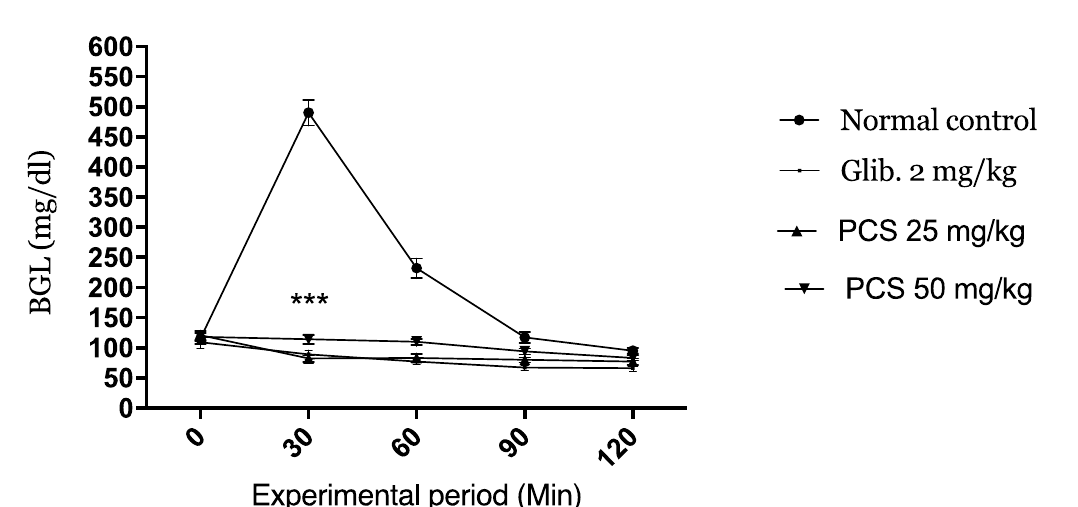
Figure 5. Effect of PCS on blood glucose level in Alloxan-induced diabetic mice during oral glucose tolerance (OGTT). Values are expressed as mean ±SD ( n = 5 mice). *** p < 0.001compared to normal control.